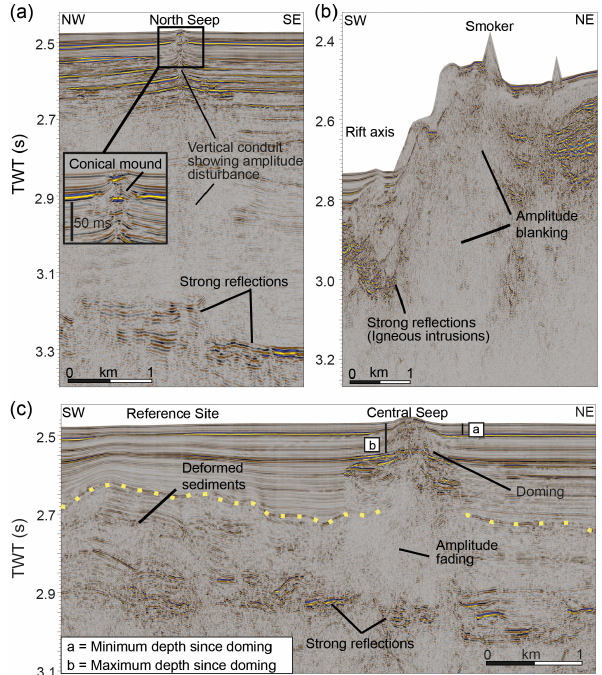
Figure 2. Seismic profiles of the North Seep (a) , Smoker Site (b) as well as of the Central Seep and Reference Site (c) . Seismic sec- tion showing doming above the Central Seep. There are different phases of onlap starting about 60ms (maximum deposition) until about 15ms (minimum deposition) or 48 and 12mb.s.f., respec- tively, assuming a sediment interval velocity of 1600ms − 1